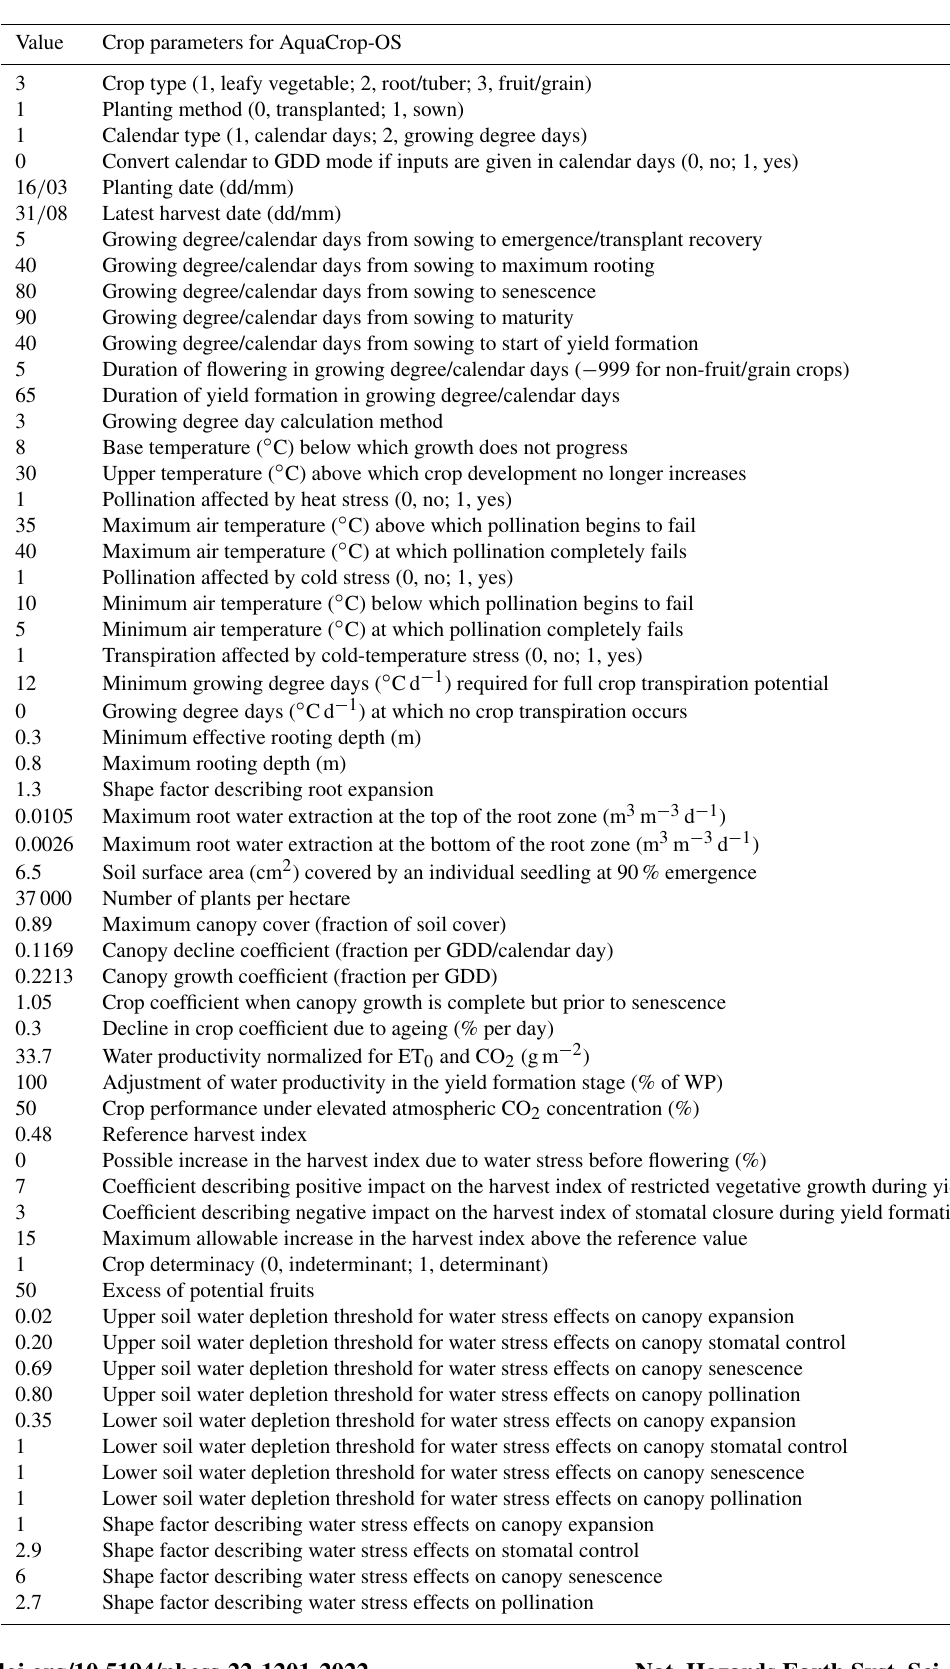
Table A4. Crop parameters for maize AquaCrop-OS in ADOPT.